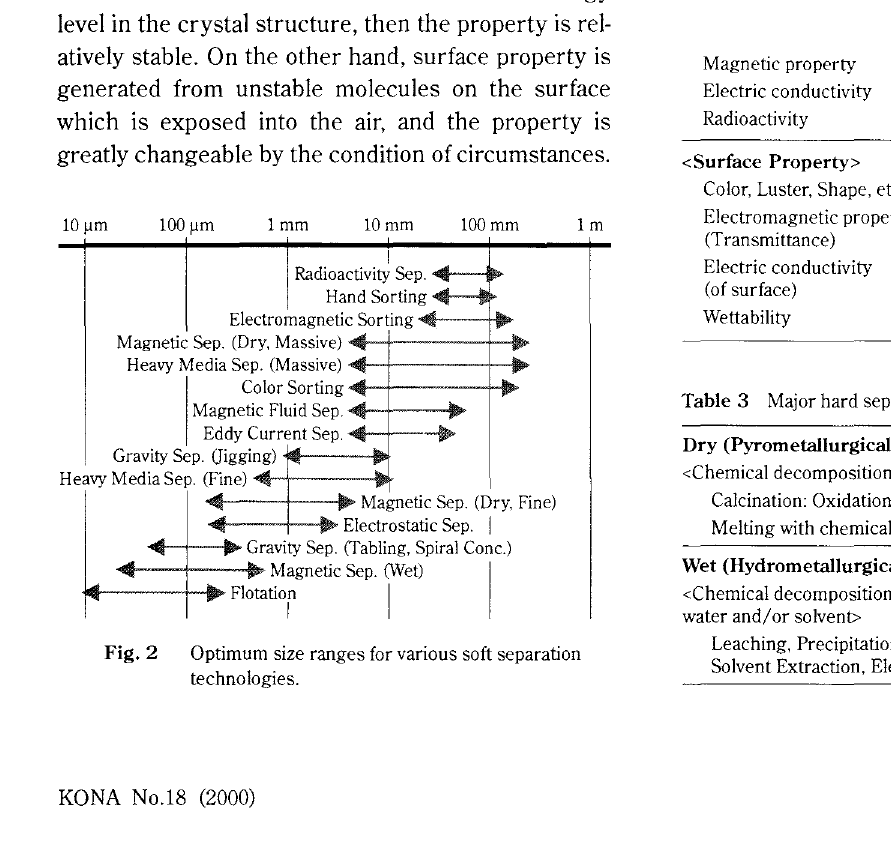
Table separation, Malti-gravity separation, etc. (Dry) Gravity separations: Air table separation, Air jigging, etc.